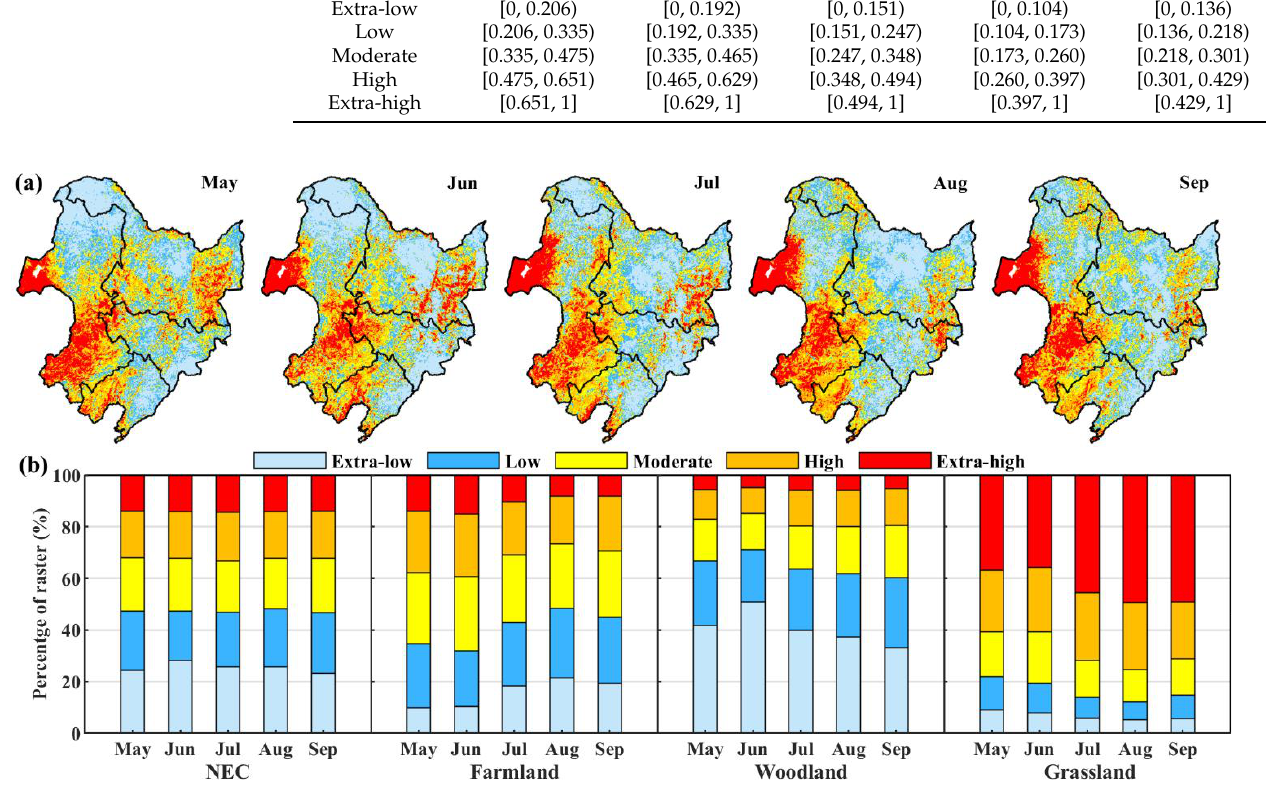
Figure 10. Spatial pattern of various levels of static agricultural drought hazard ( a ) and statistics ( b ) during the growing season in NEC.